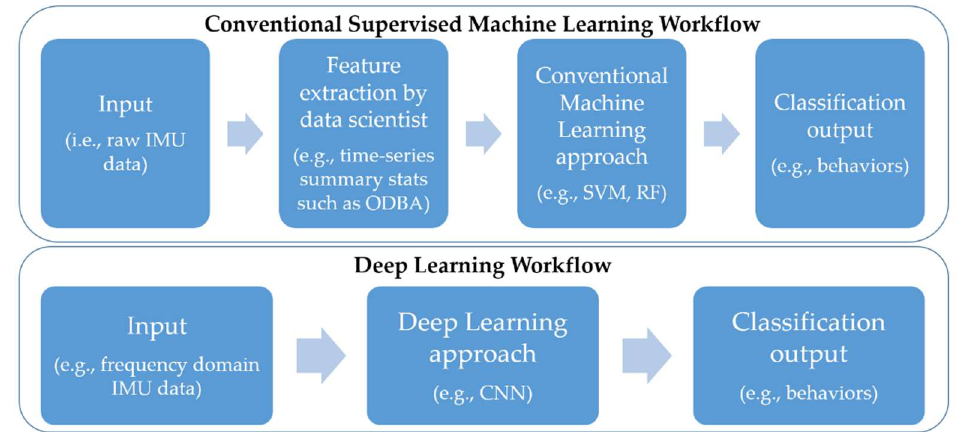
Figure 1. Simplified schematic showing the workflow of conventional machine learning approaches versus deep learning approaches. IMU = inertial measurement unit, ODBA = overall dynamic body acceleration, SVM = support vector machine, RF = random forest, CNN = Convolutional Neural Network.